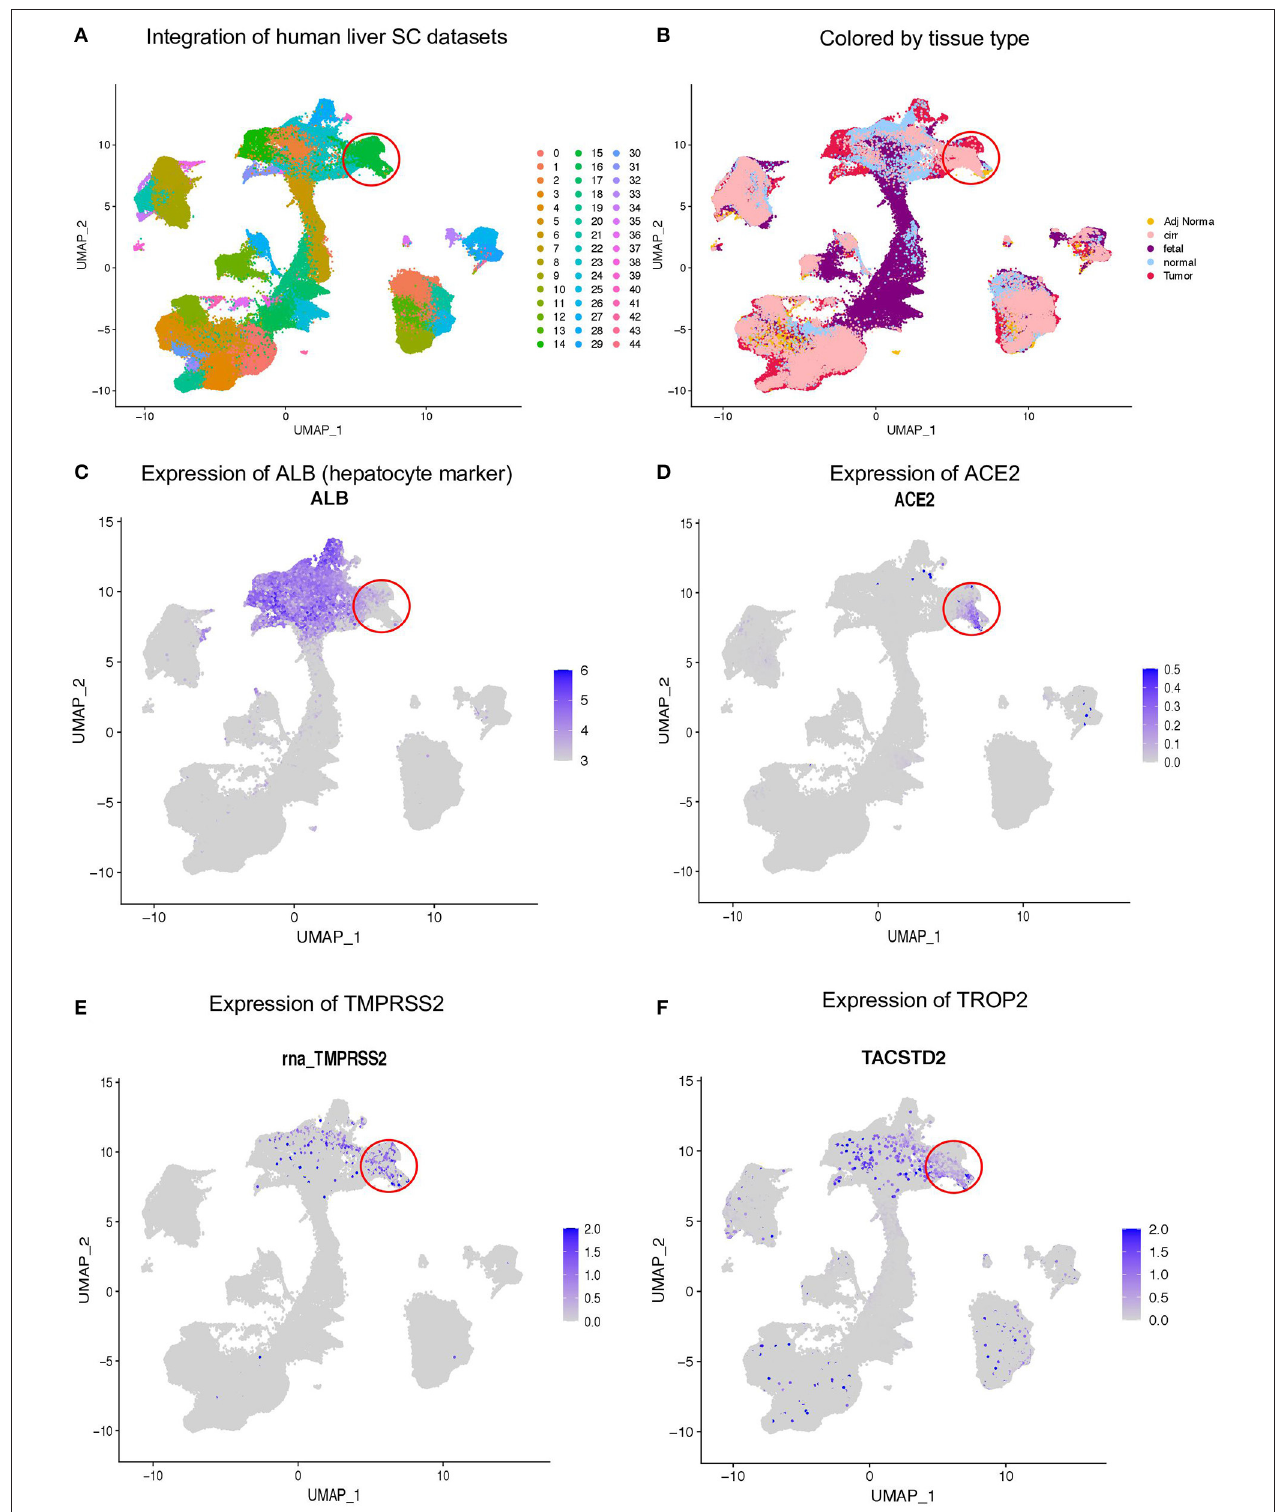
FIGURE 1 | Expression of ACE2 and TMPRSS2 in human liver. (A) Integration of ∼ 300,000 sc-RNA-seq libraries from fetal, adult normal, cirrhotic, and HCC patients, which identified 45 clusters in the human liver. (B) Louvain clusters, colored by tissue types. Expression of (C) ALB, (D) ACE2, (E) TMPRSS2, and (F) TROP2.